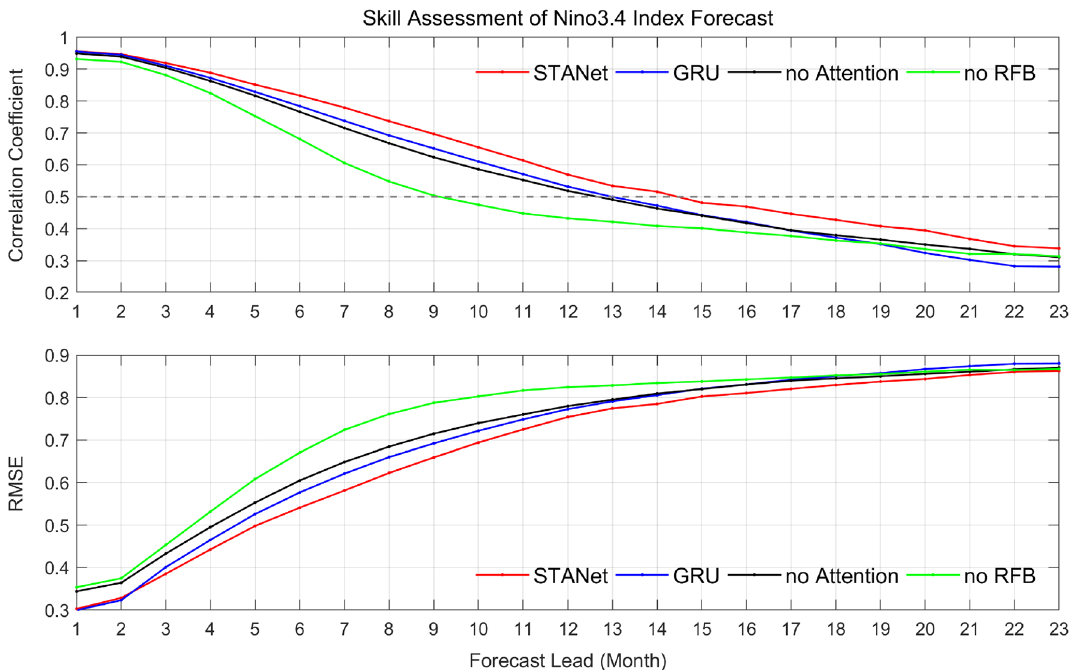
Figure 7. Time series of correlation coefficient ( CC ) and the root-mean-square-error ( RMSE ) for 23-month forecast lead time of the proposed STANet with 3 cases of ablation experiments for the test period of 1980–2017. “ STANet ” is the proposed architecture. “GRU” is an alternative model using GRU module 29 instead of the LSTM module. “no Attention” indicates the STANet without attention mechanism. “no RFB” indicates the STANet using 3D convolution layers instead of the receptive field blocks. Lower RMSE and higher CC indicate better performance in Nino3.4 index prediction.